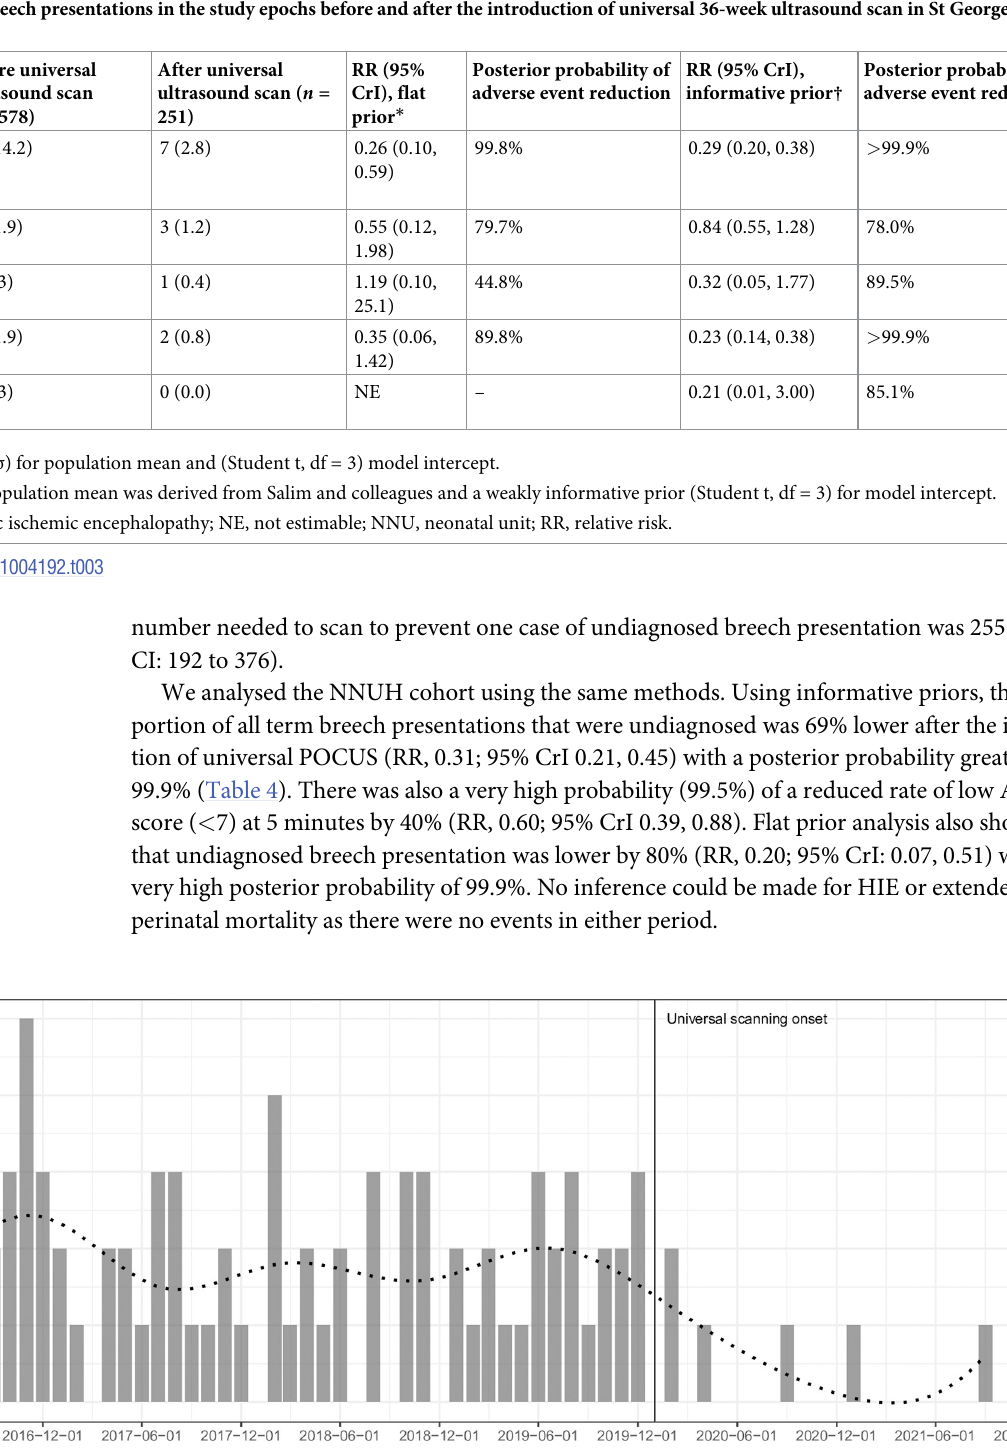
Fig 1. The number of term breech presentations that were undiagnosed during the study period in St. George’s University Hospital. Dotted line represents the fitted regression curve with